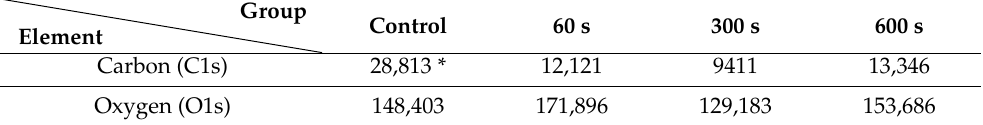
Table 2. X-ray photoelectron spectroscopy C1s & O1s counts/s following plasma treatment.